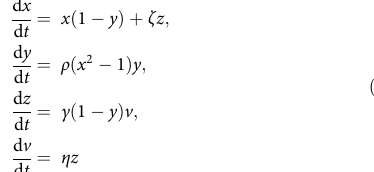
Fig. 6 Analogue interpolation of the gate activation curves and gate kinetics. a Sigmoidal currents I 1 þ (cid:8)(cid:8)(cid:8) þ I N are summed to interpolate the activation curve of an ionic gate. The adjustment parameters are the voltage thresholds V t 1 ; ¼ ; V tN and source currents I channel of a thalamic relay neuron (circle symbols) 45 interpolated by nine sigmoids whose sum gives the output current I current normalized by I I I gives the biological activation curve, m max ¼ max ; 1 þ (cid:8)(cid:8)(cid:8) þ max ; 9 summing N bell-shaped curves centred at